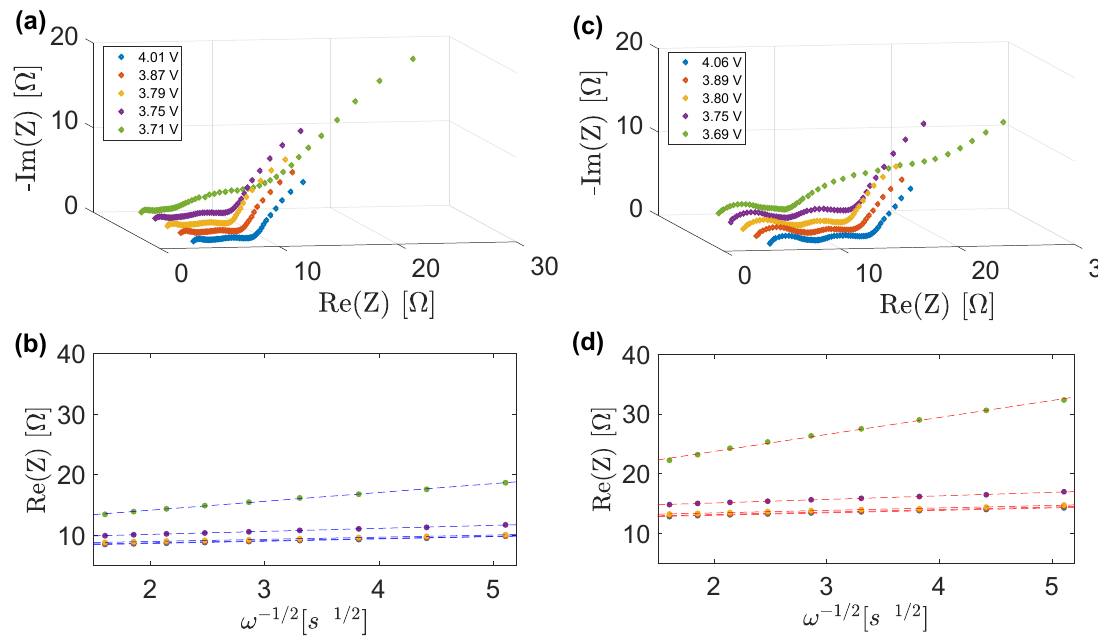
Figure 8. Samples of impedance spectra and corresponding linear fits for uncycled ( a , b ) and cycled ( c , d )